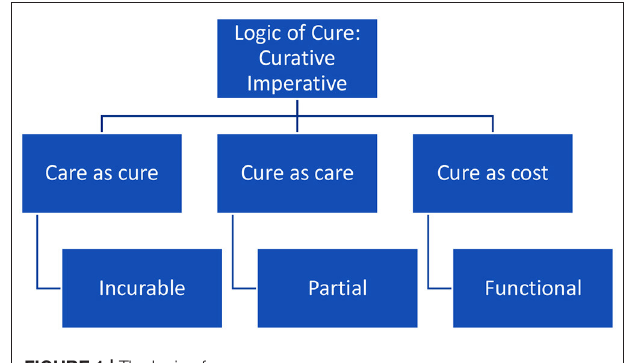
FIGURE 1 | The logic of